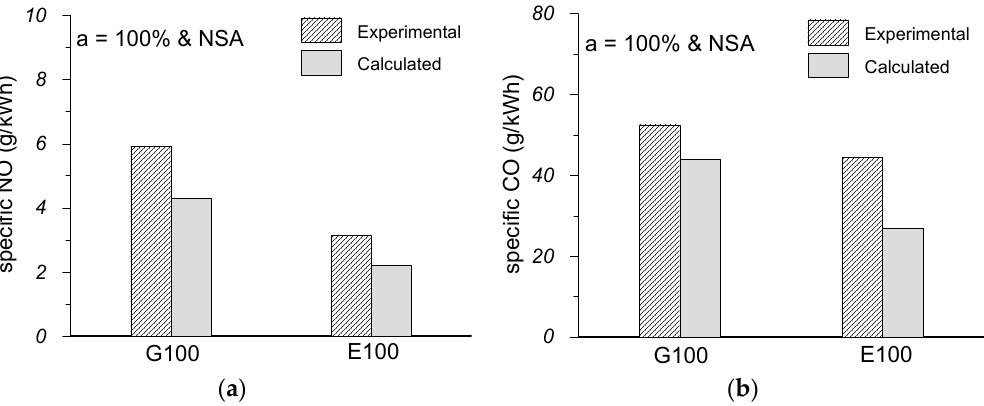
Figure 3. Comparison between calculated and experimental values of specific NO concentration ( a ); and specific CO concentration ( b ); of the “DatsuL200” engine running at 100% of full engine load and 2400 rpm engine speed with normal spark timing, under G100 or under E100, fuel operating modes.